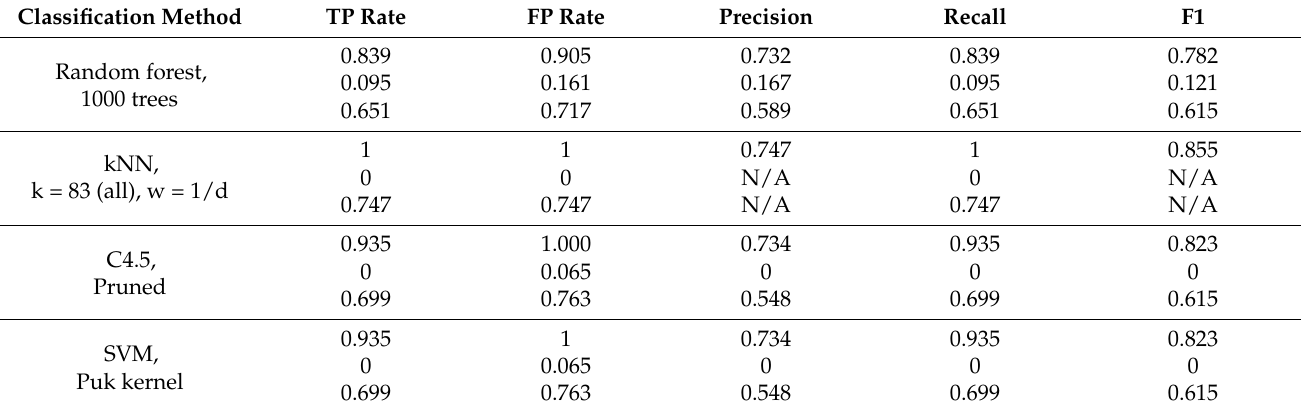
Table 9. Precision and recall analysis for the original